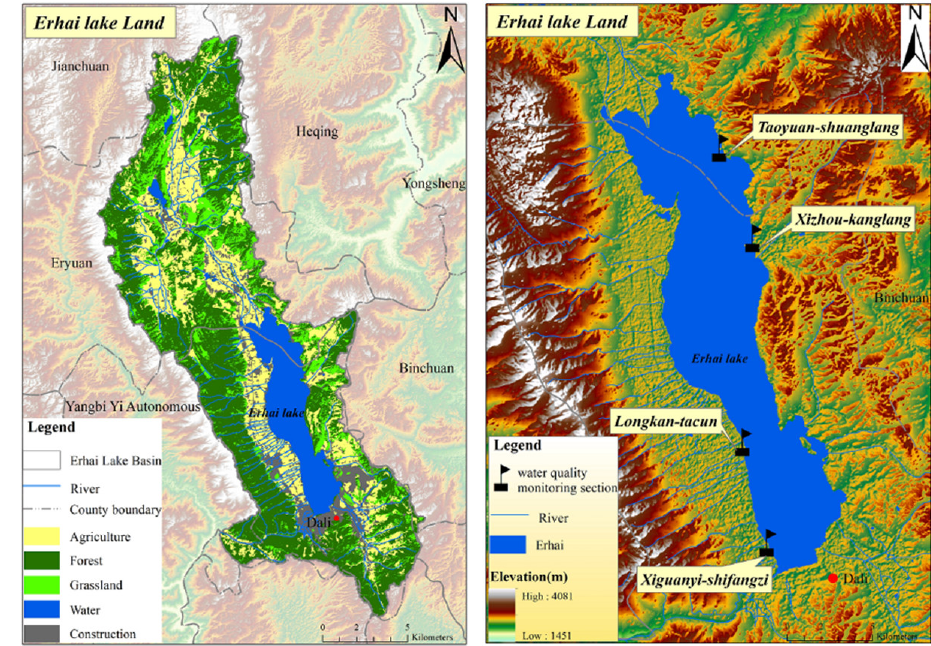
Figure 1. Location of the Erhai Lake basin and Erhai.